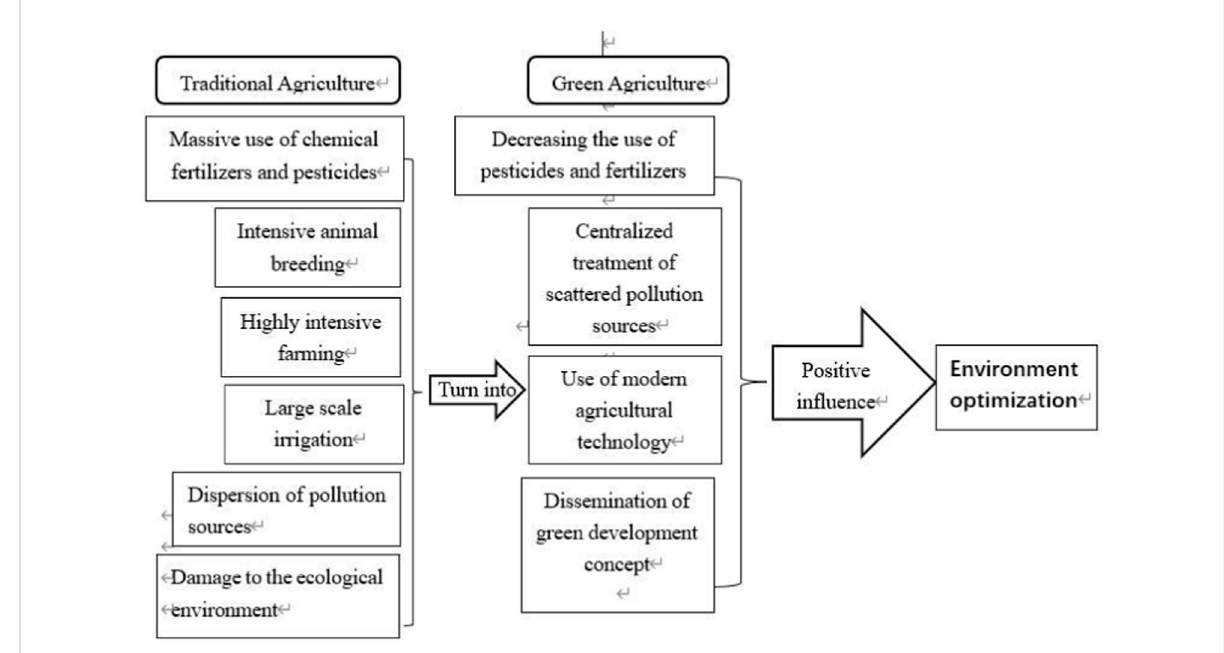
FIGURE 1 Theoritical analysis of green agriculture development on environment